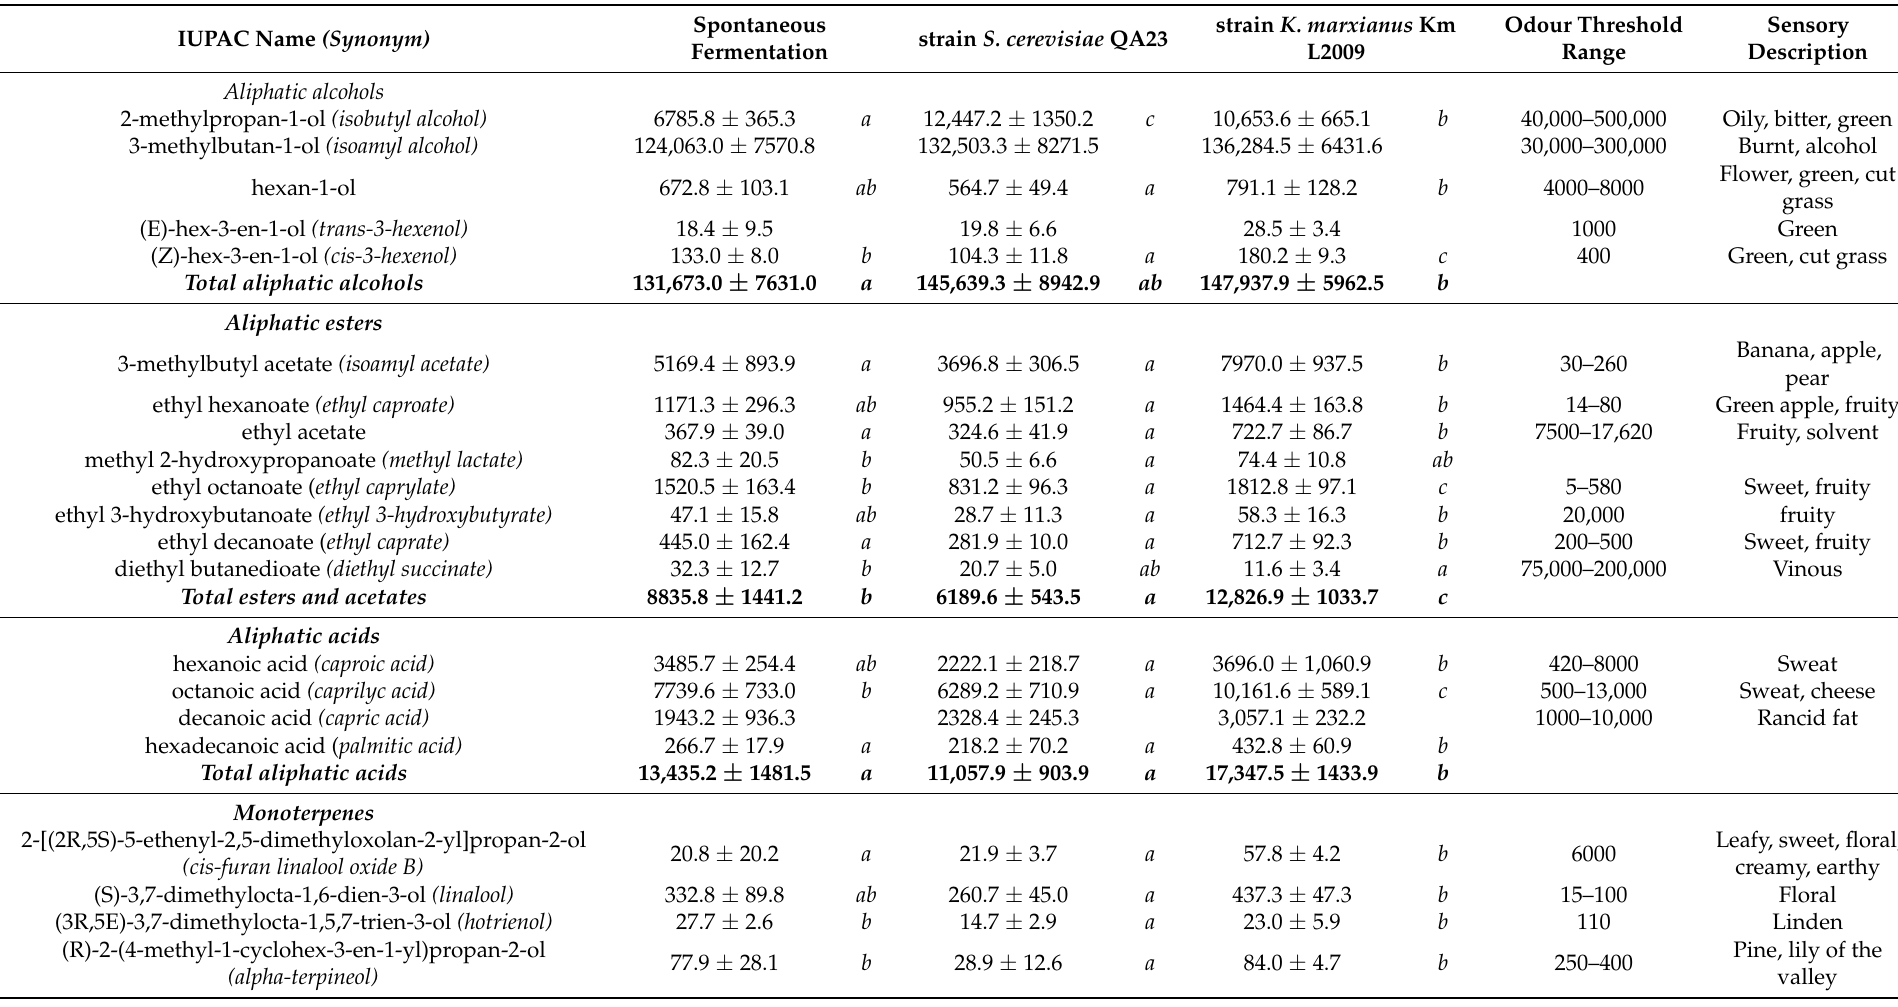
Table 4. Free volatile compounds (in µ g/L) found in Muscat of Alexandria wines. Odor thresholds and sensory descriptions according to